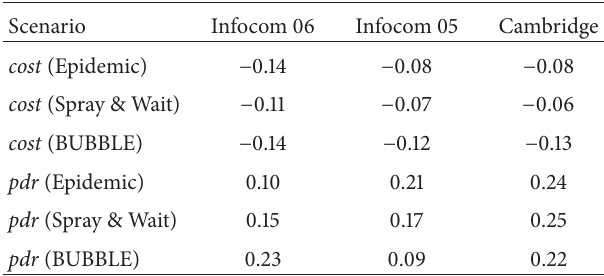
Table 6: The average error percentage of all fragments in each separate